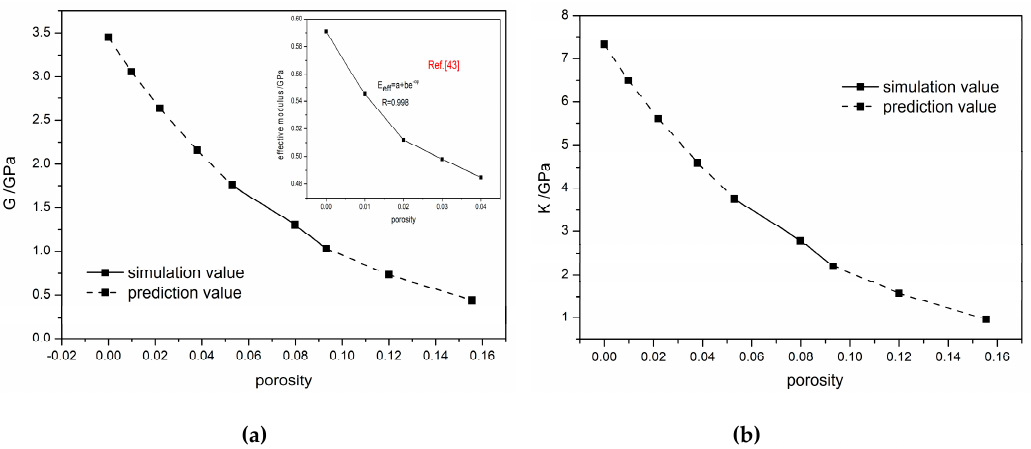
Figure 9. Prediction results of ( a ) shear modulus and ( b ) bulk modulus of PBX, also shown in ( a ) as the simulation results curve from reference [43].